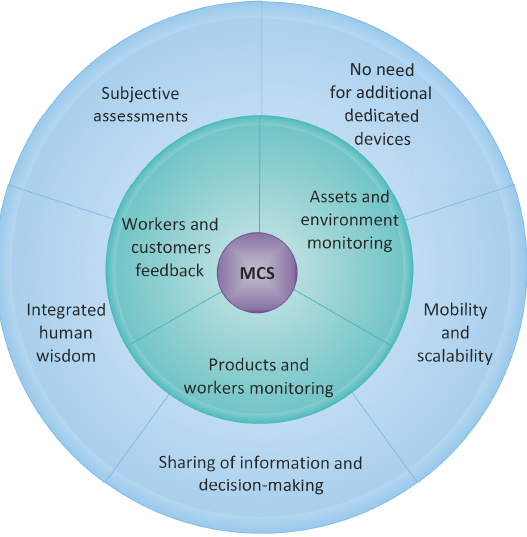
Figure 3. The advantages of using mobile crowdsensing and mobile crowdsourcing in Industry